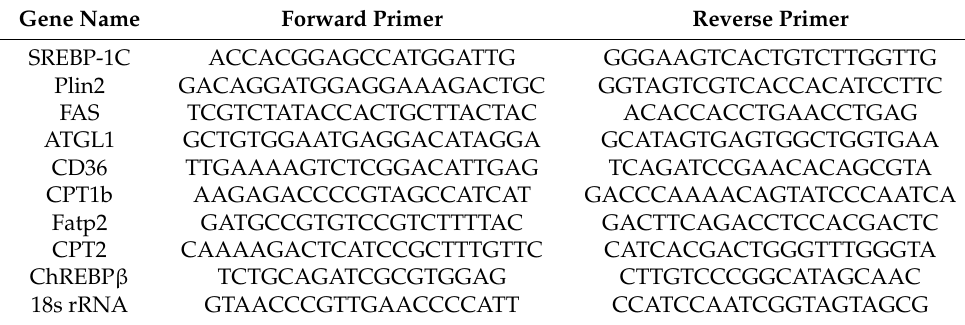
Table 1. Primers used in the